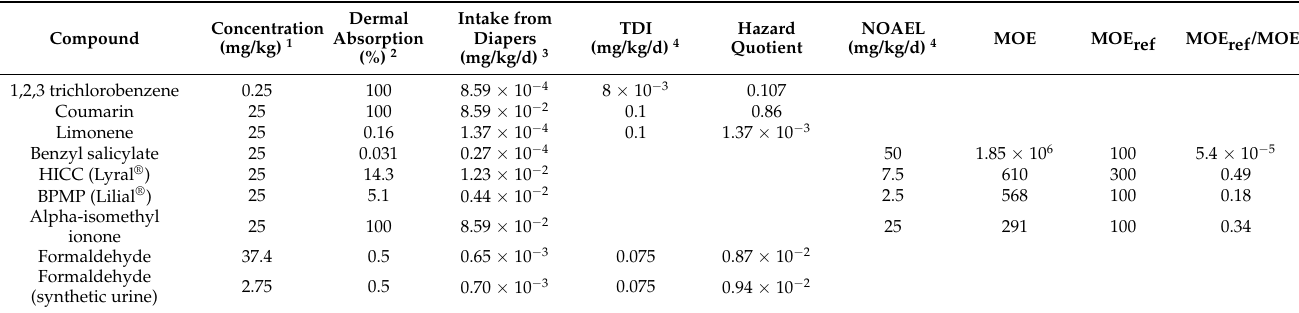
Table 9. Risk assessment of other compounds detected or quantified in diapers at potentially unsafe levels according to ANSES by taking into account the fractional dermal and oral